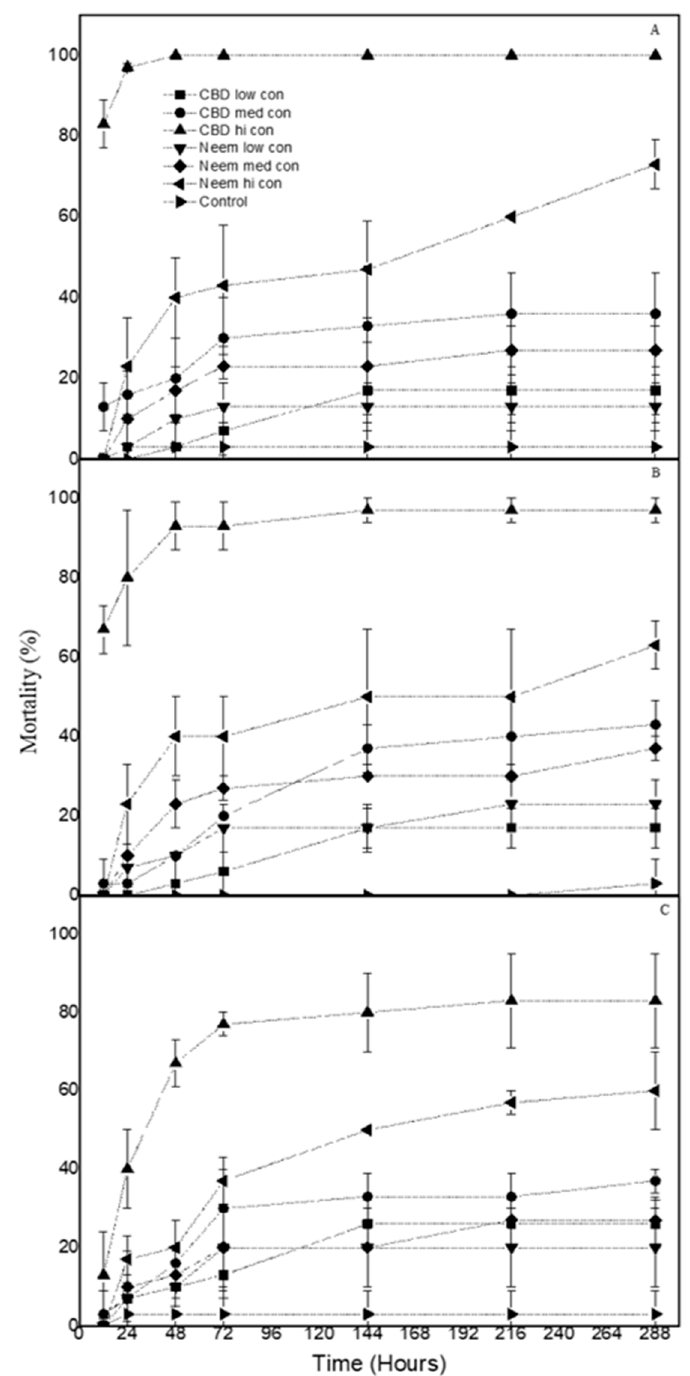
Figure 1. Mean mortality (% ± sd) of T. confusum larvae treated with CBD oil and neem oil at three concentrations on ( A ) wheat ( B ) corn and ( C ) rice. (low con: 15 mg/mL, med con: 45 mg/mL, hi con: 90 mg/mL).